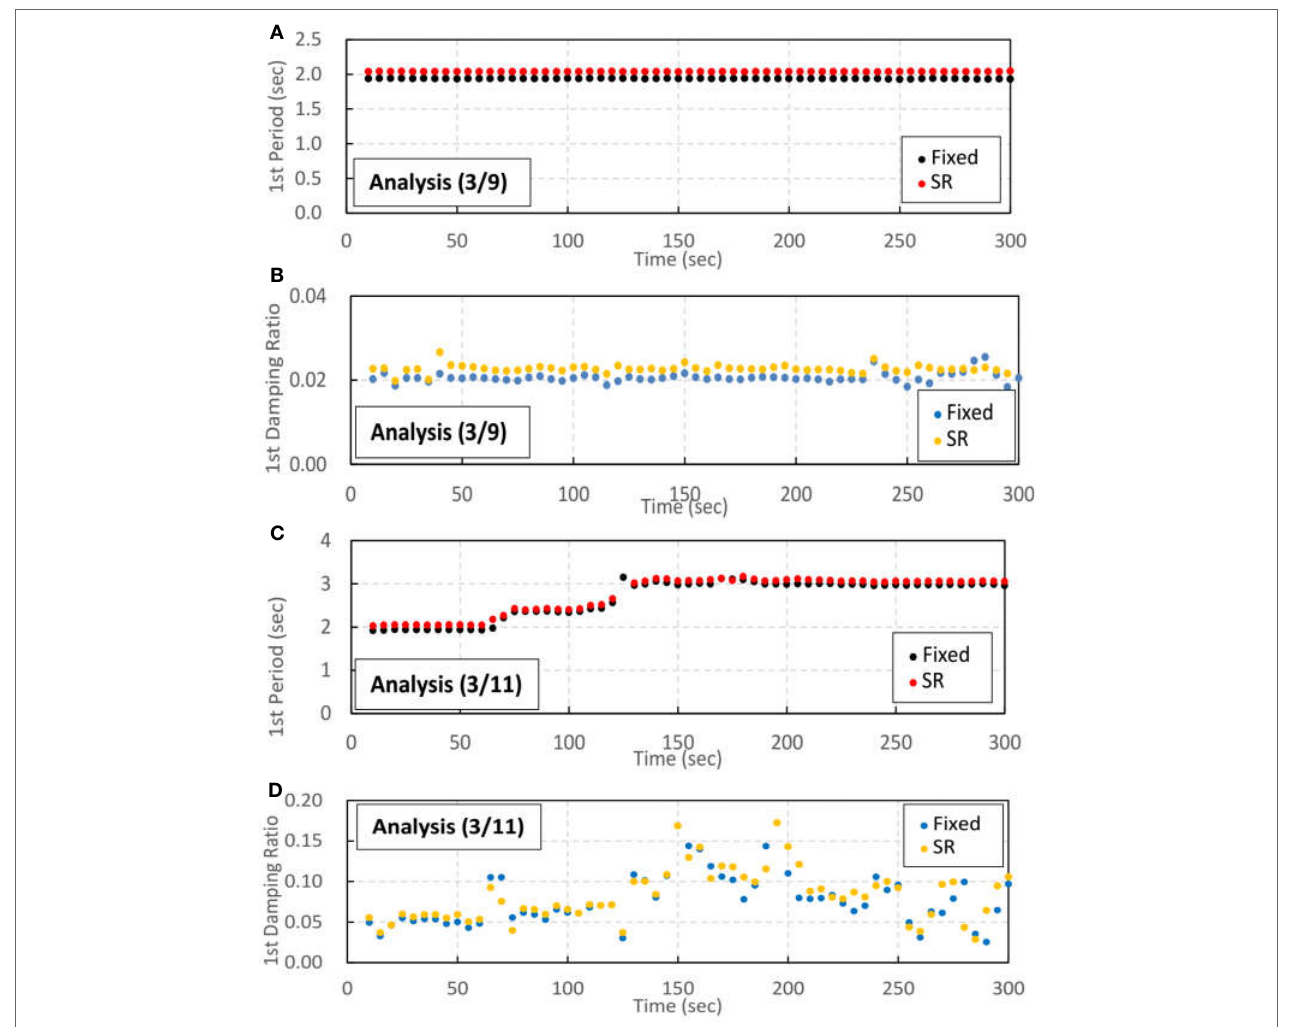
FigUre 15 | Comparison of analytical results for the “fixed” and “SR” models (N–S direction): (a) first natural periods during the 3/9 pre-shock, (B) first damping ratio during the 3/9 pre-shock, (c) first natural period during the 3/11 main shock, and (D) first damping ratio during the 3/11 main